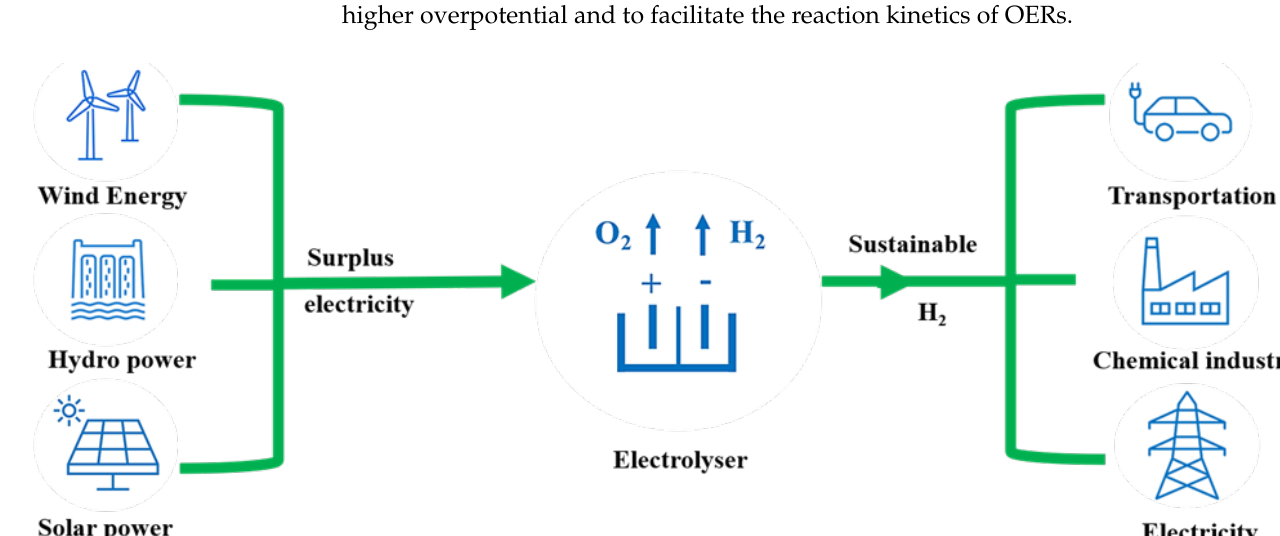
Figure 1. Overview of a sustainable hydrogen production from water electrolysis and its application in different sectors.